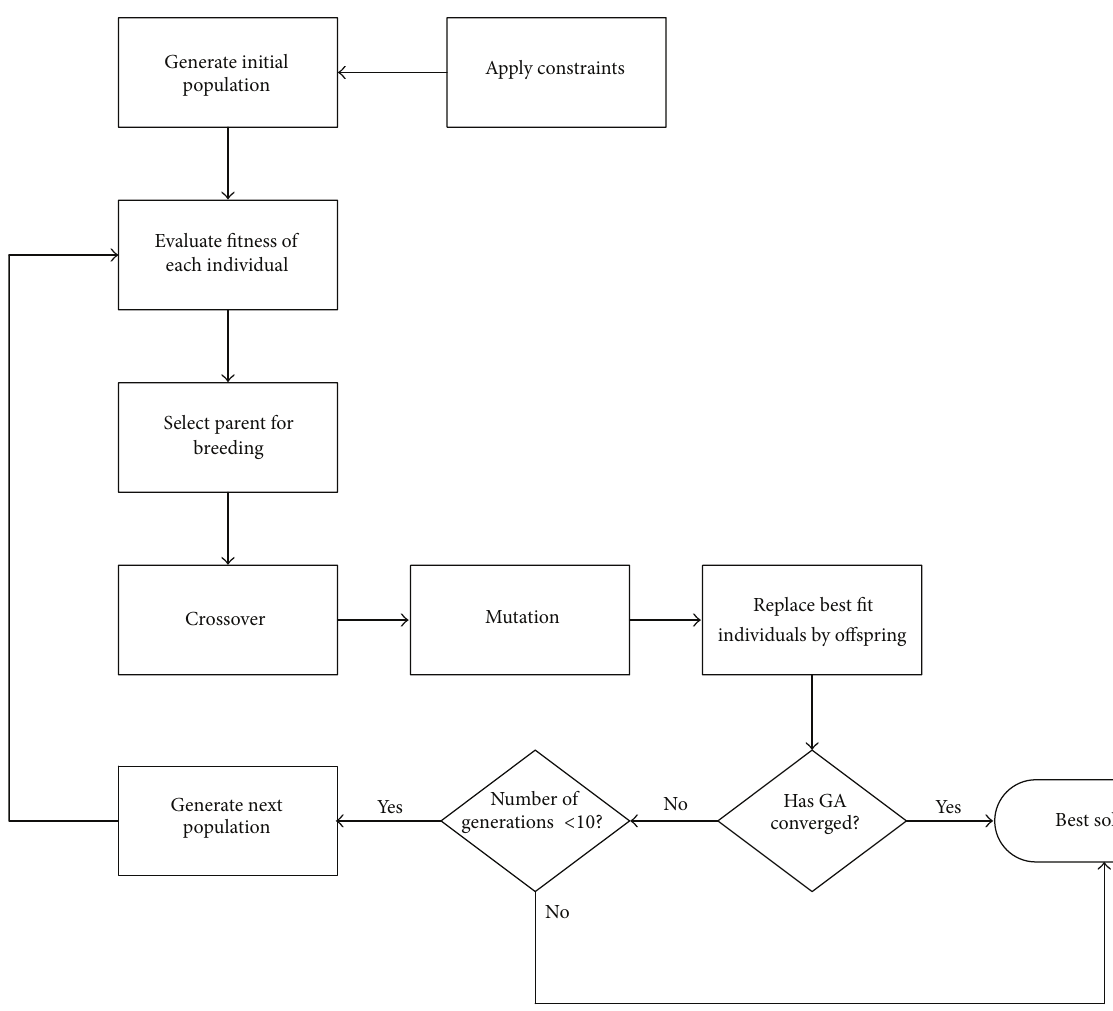
Figure 1: Flowchart for the optimization